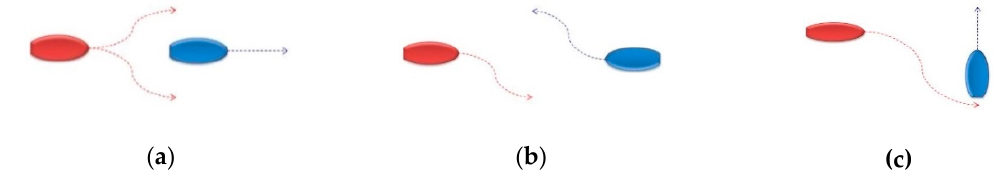
Figure 8. The path of steering for collision avoidance in the COLREGs situations: ( a ) Overtaking; ( b ) head-on situation, and ( c ) crossing situation.